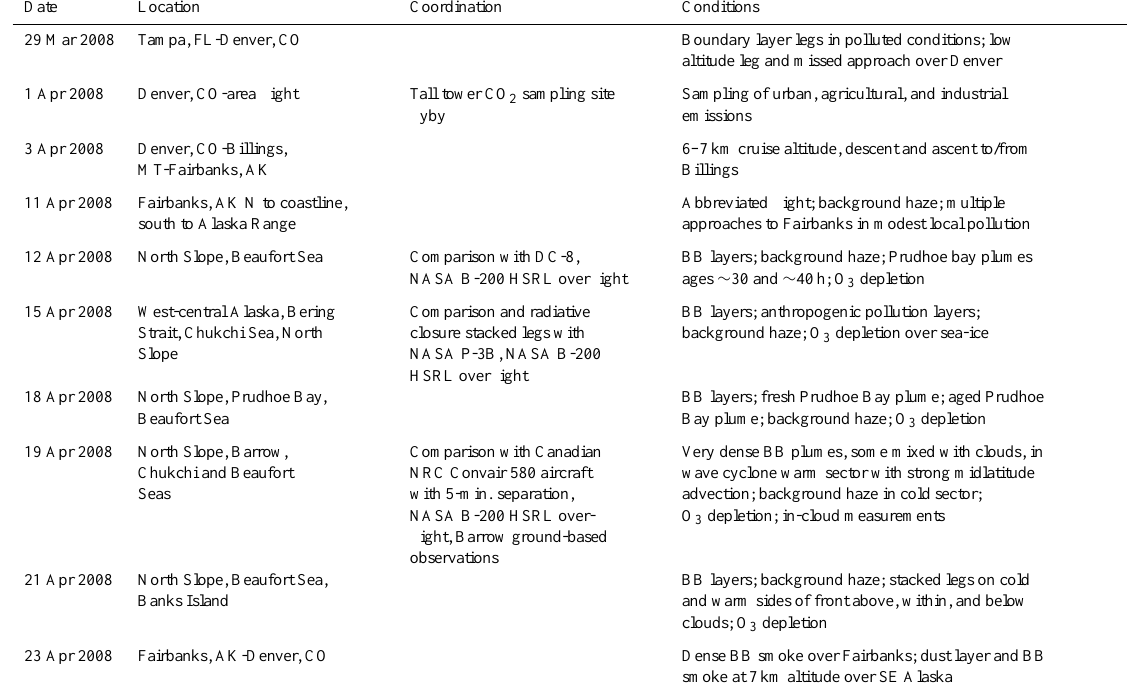
Table 2. Flights times, locations, coordination with other platforms, and conditions encountered. Location Coordination Conditions